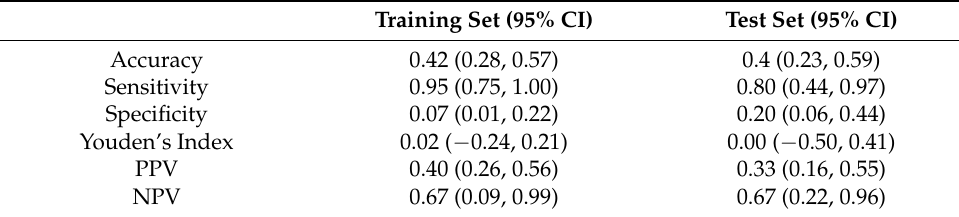
Table 3. Skill scores for the radiological readers.